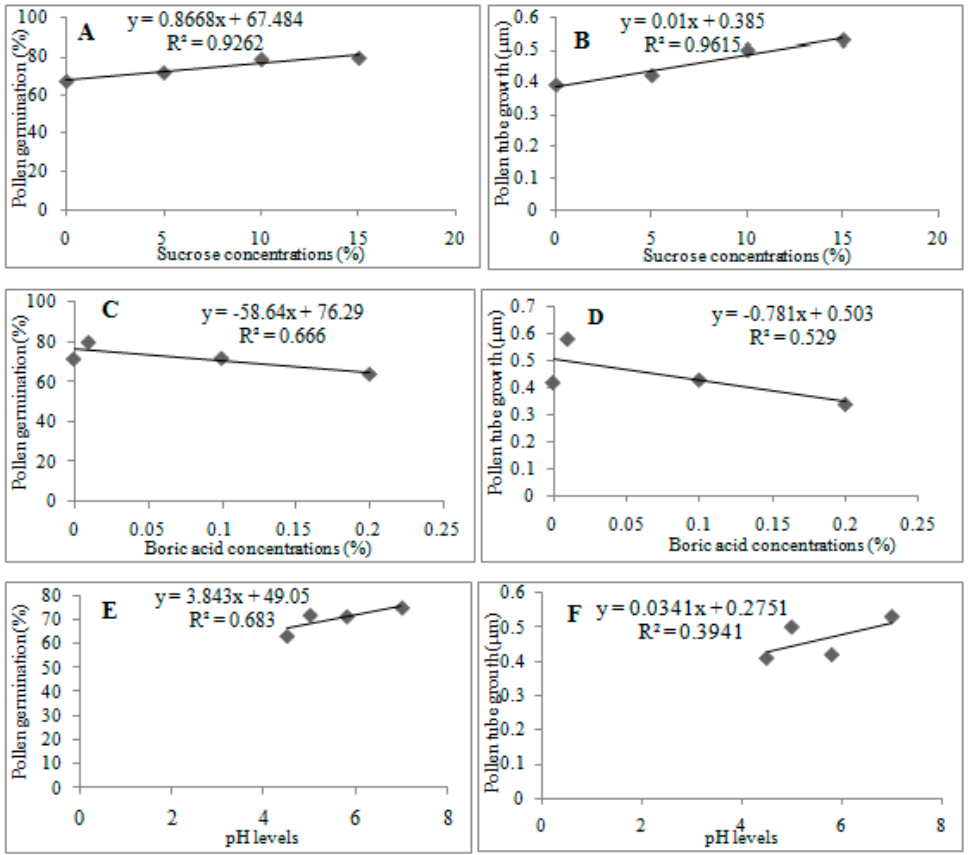
Figure 2. The relationships between sucrose, boric acid, and pH and pollen germination and tube growth: ( A , B ) Showed strong positive relationship between sucrose concentrations, pollen germination, and tube growth, ( C , D ) showed strong negative relationship between boric acid concentrations, ( E , F ) had strong positive relationship between pH levels and pollen germination and tube growth.